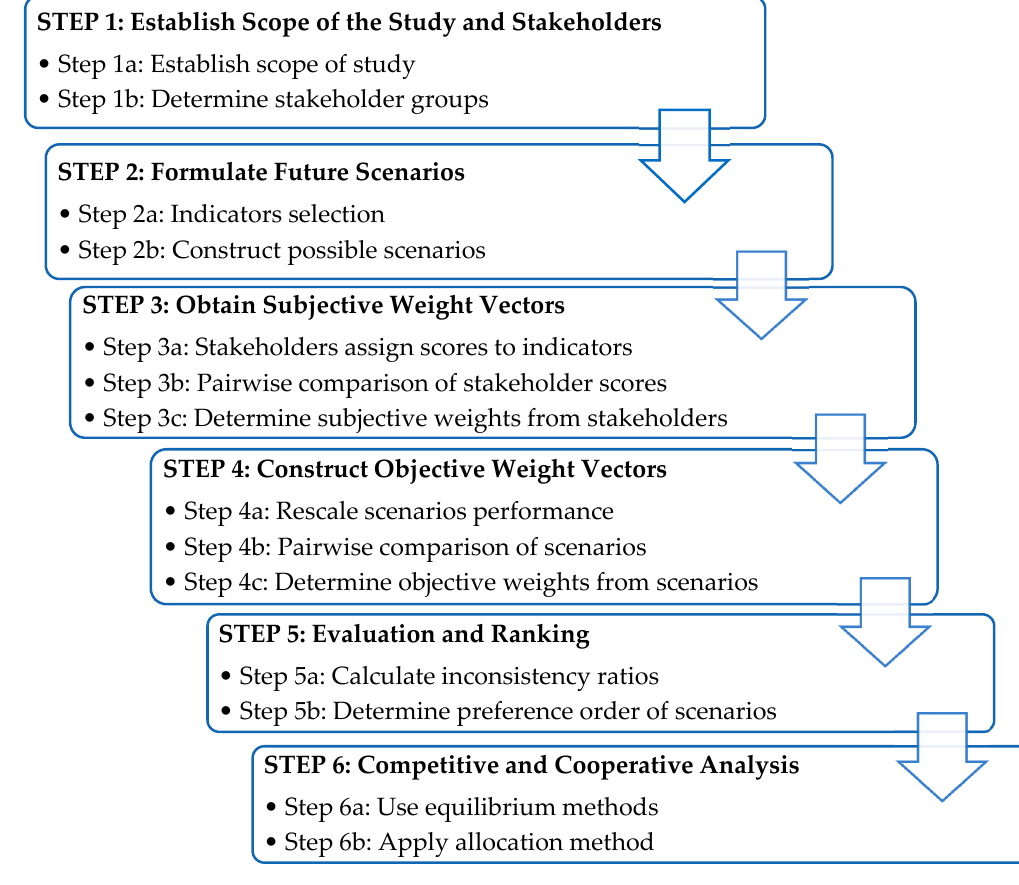
Figure 1. Flowchart summarising the methodology.